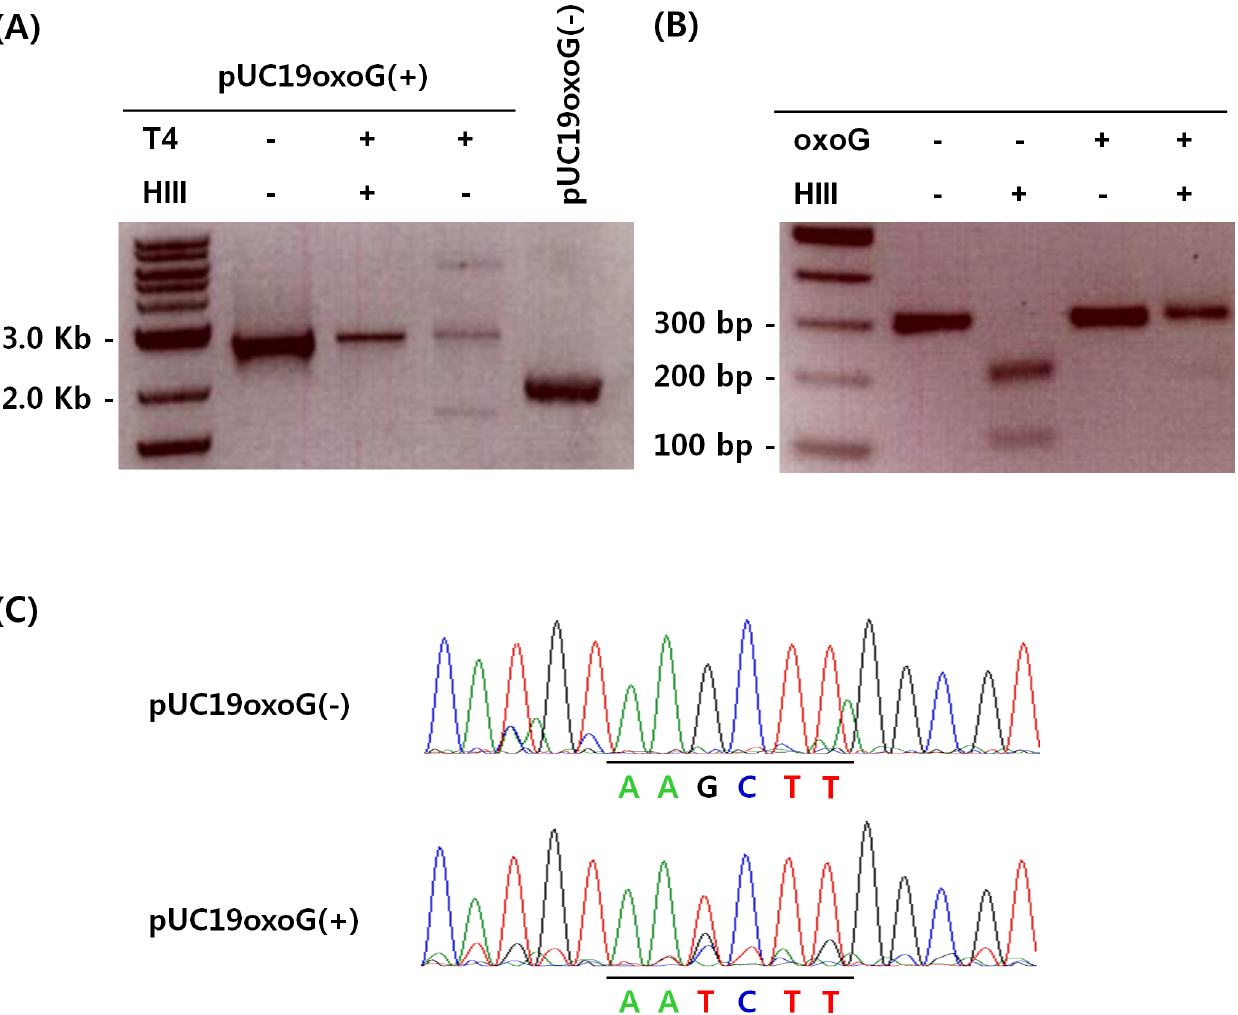
Fig 1. Establishment of the Hoogsteen base pairing-mediated PCR-Sequencing assay for 8-oxoG lesions in DNA. (A) pUC19oxoG(+) was prepared by site-directed mutagenesis, (B) 8-oxoG lesion was identified by Hind III resistance, and (C) Hoogsteen base pairing-mediated 8-oxoG to T transversion. T4: T4 DNA ligase, HIII: Hind III restriction enzyme.